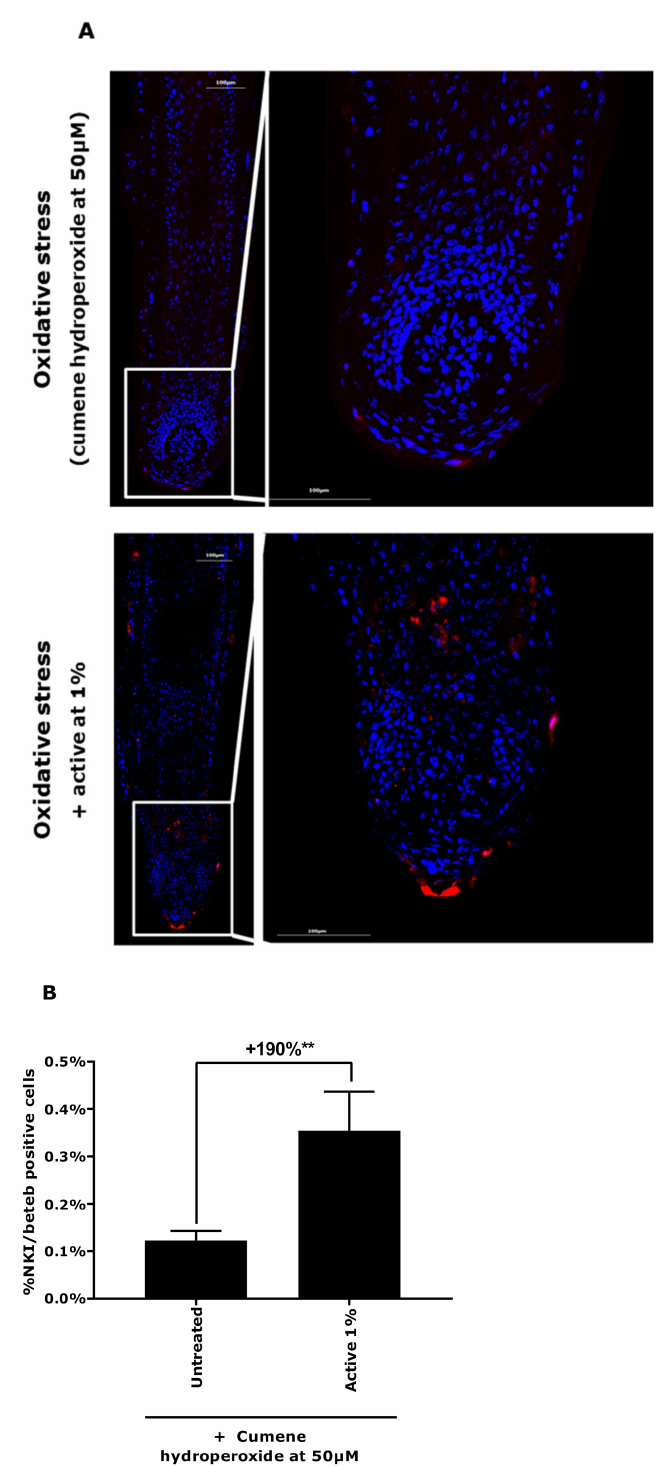
Figure 6. Melanocyte and melanoblast quantification by NKI/beteb immunostaining in a canities- induced condition (cumene hydroperoxide at 50 µ m) in the presence of active ingredient at 1% in hair follicles. ( A ) Representative images. Magnification: 10 × . ( B ) Data are presented as mean ± SEM. Statistical analysis was performed using one-way ANOVA with permutation test followed by a t -test with permutation, with ** p <